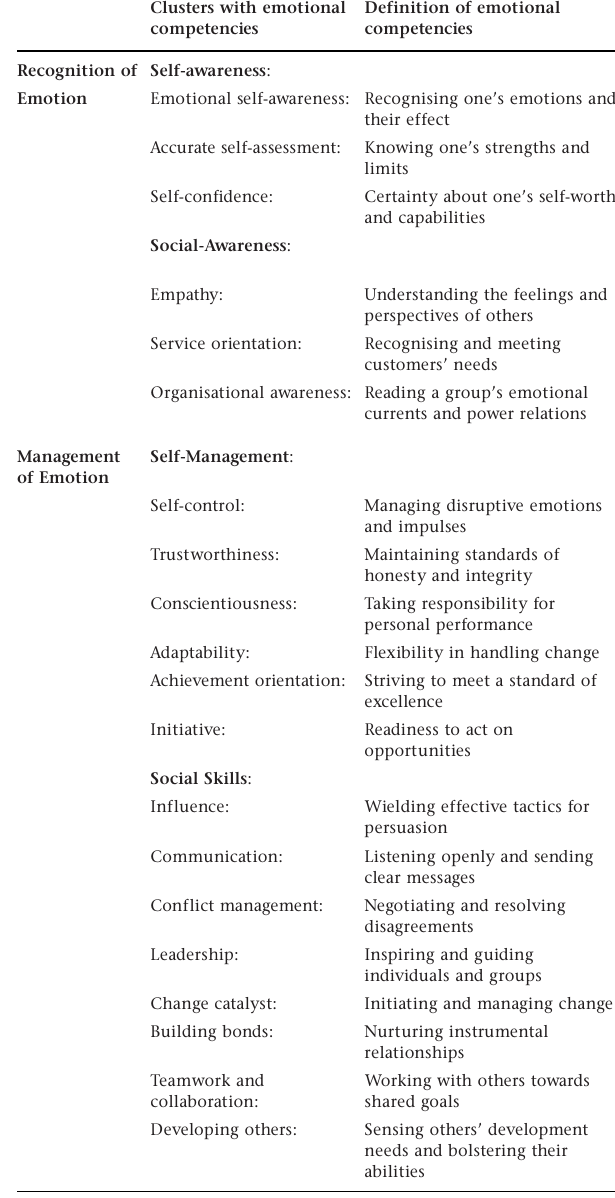
E MOTIONAL COMPETENCY FRAMEWORK Clusters with emotional Definition of emotional